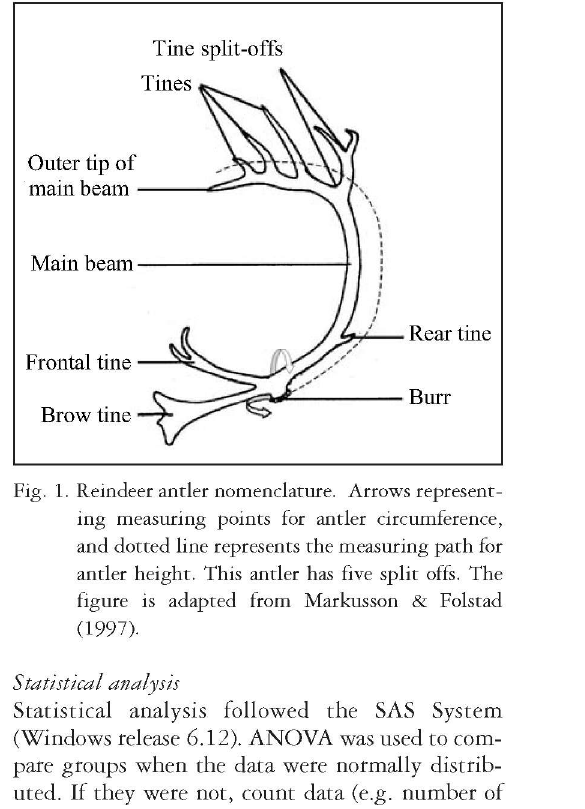
Fig. 1. Reindeer antler nomenclature. Arrows represent ing measuring points for antler circumference, and dotted line represents the measuring path for antler height. This antler has five split offs. The figure is adapted from Markusson & Folstad